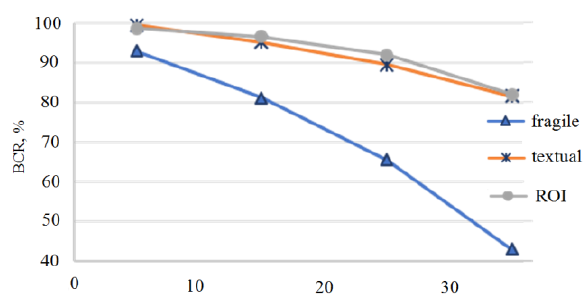
Figure 8. Watermark distortions under JPEG